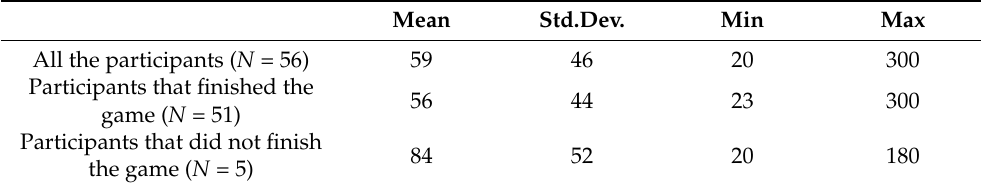
Table 2. Duration (in minutes) of playing SQL